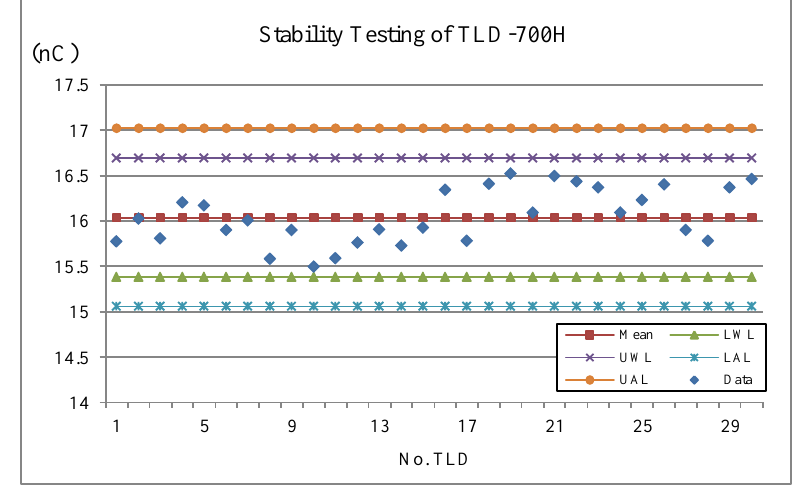
Figure 6a. Stability testing of TLD-700H by using 90 Sr